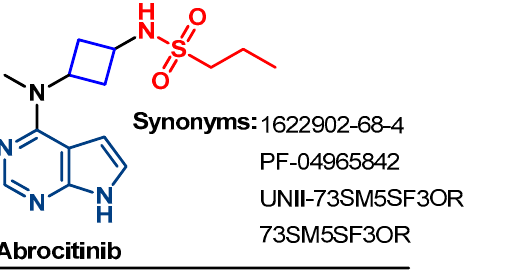
Figure 11. Chemical structure/name/synonyms of abrocitinib.